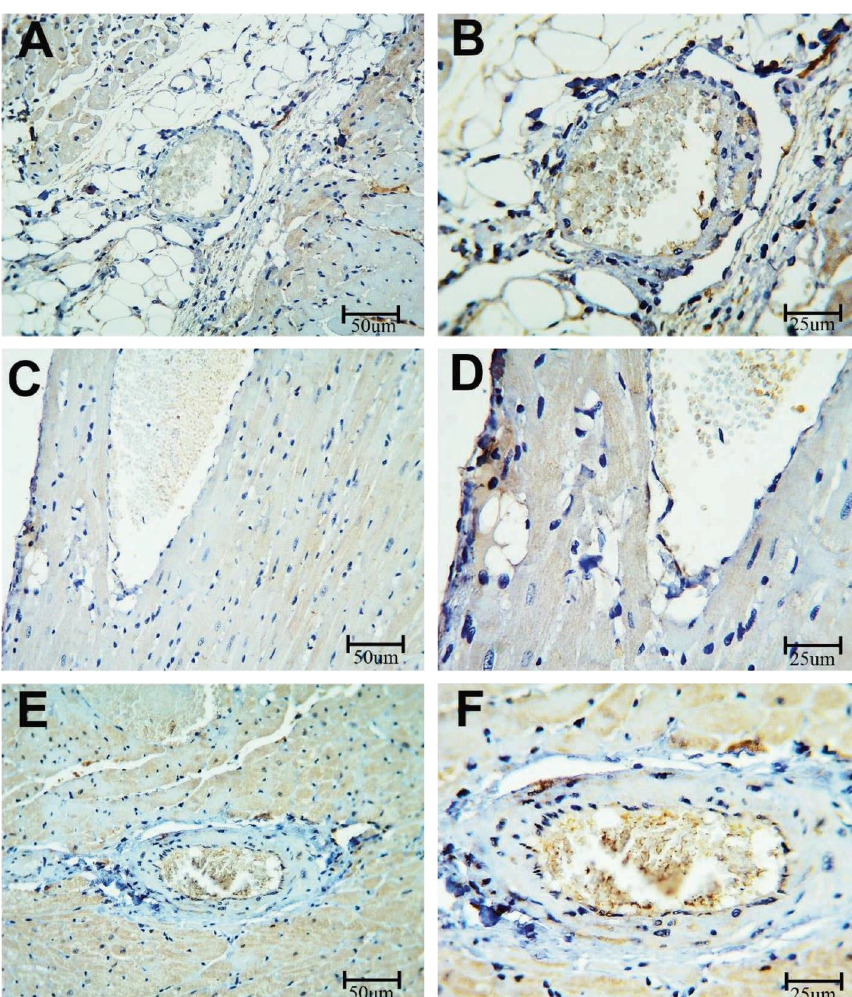
Figure 9: Histopathological section in the coronary artery of rat stained with eNOS immune stain. a and b are the control group, c and d are the BPA group, and e and f are the BPA+LC group. Te coronary artery of the control group shows a minimal expression of the dye in the wall of the artery. Te expression of the color is notably increased in the BPA group and reduced in the BPA+LC group (eNOS immune stain; A, C, and E X 200; B, D, and F X